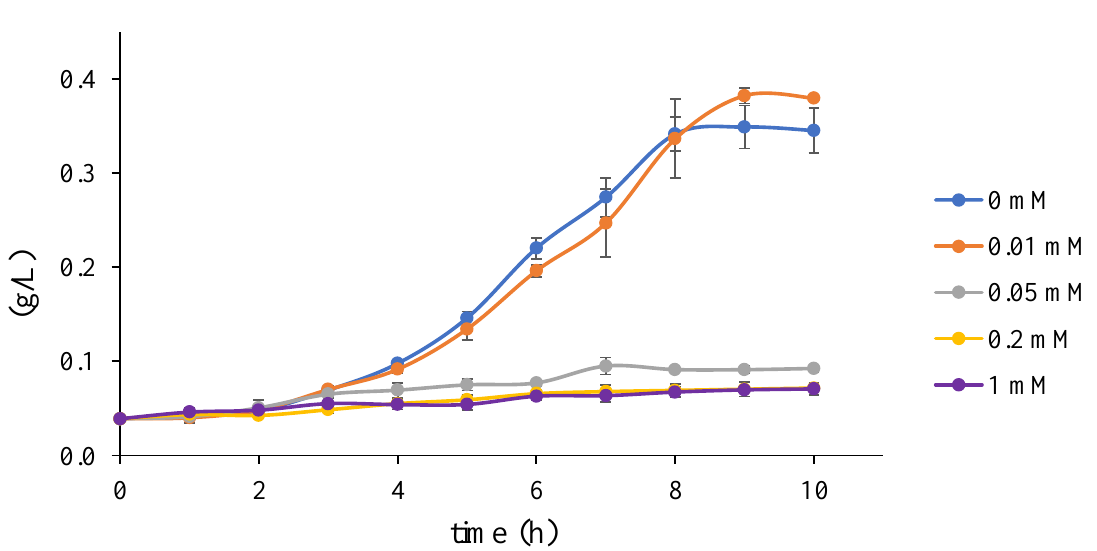
Figure 7. Bacterial population growth data reflecting concentration of inducer. The plot shows curves of population growth on GLY for cultures reflecting different concentrations of IPTG prepared according to Section 2.1.4. All cultures—carrying plasmids with heterologous metabolic pathway—started at the same value but ended with different size of population depending on the initial concentration of the inducer (IPTG 0 ): 0, 0.01, 0.05, 0.2, and 1 (mM). Note that the rising amount of IPTG led to progressive inhibition of bacterial growth. The most interesting is the big step from 0.01 to 0.05 of IPTG. This notable difference in the population on the relatively small interval of IPTG values and minimal changes in the population for the rest of IPTG concentrations shows the high sensitivity of the population to IPTG 0